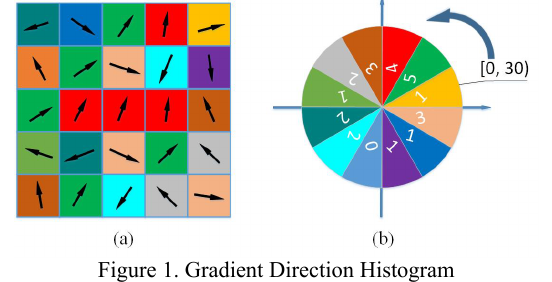
Figure 1. Gradient Direction